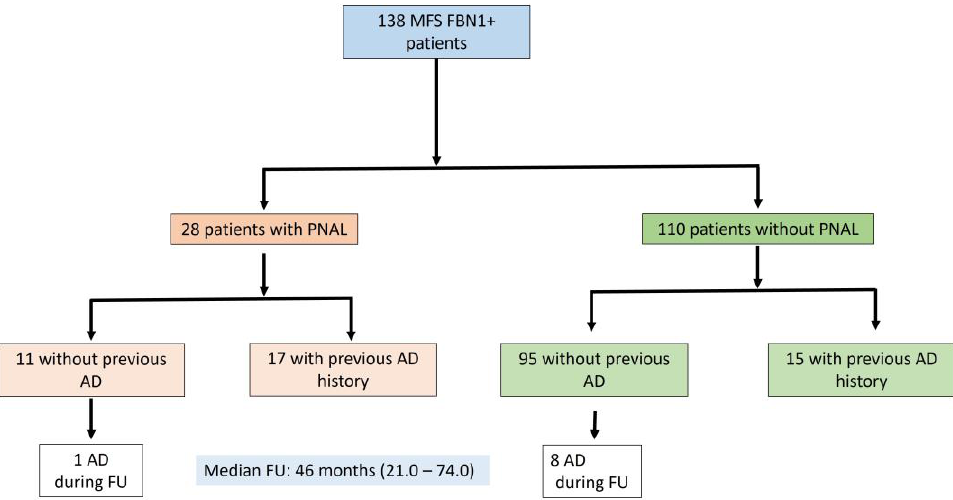
Figure A1. Study flowchart of the cohort, stratified by history and outcomes during follow-up of aortic dissection (AD). PNAL: primary non-aortic lesion.